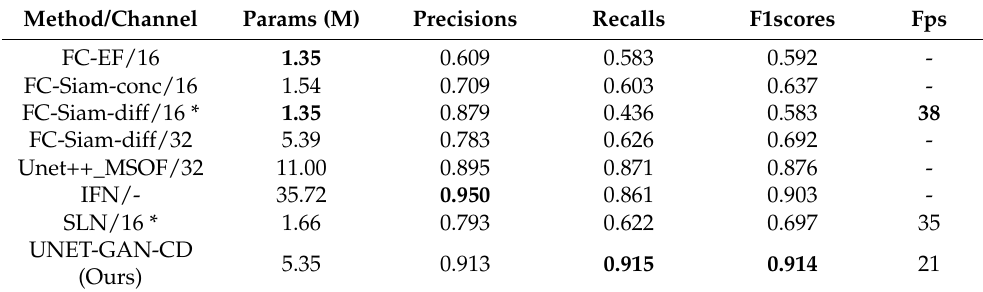
Table 6. Accuracy comparison of change detection results.